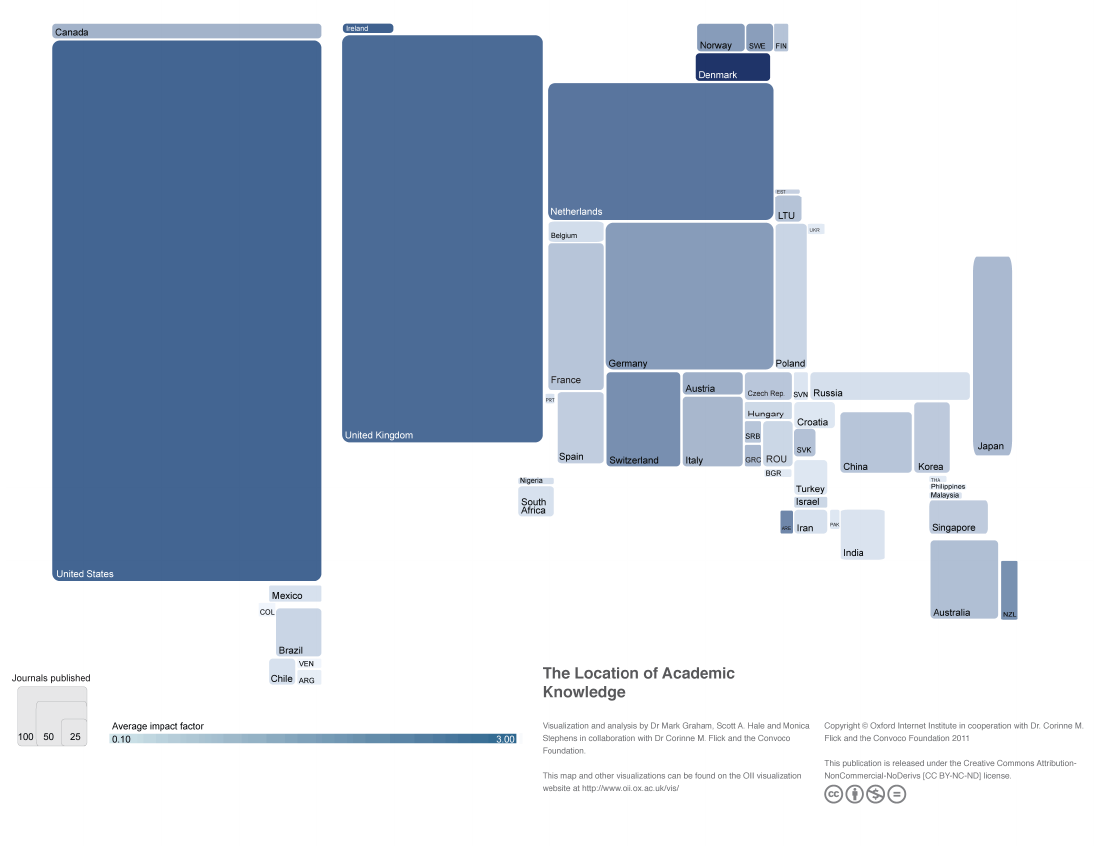
Figure 1: The location of academic knowledge Source: Graham, Hale and Stephens 2011: